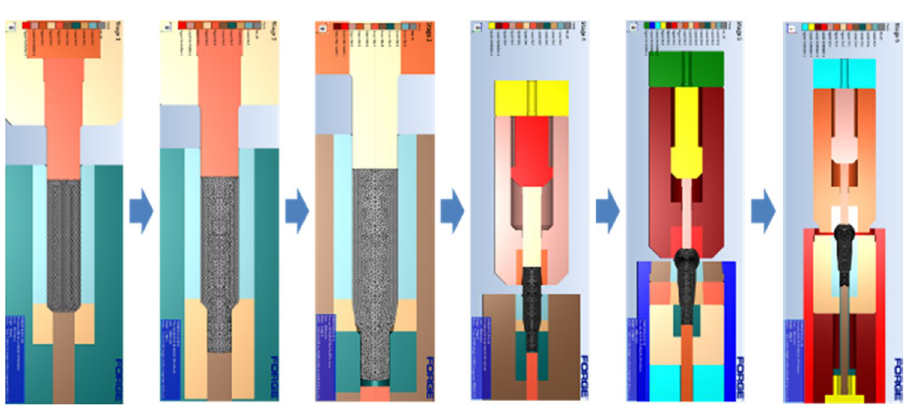
Figure 7. FE modeling of ball stud forming